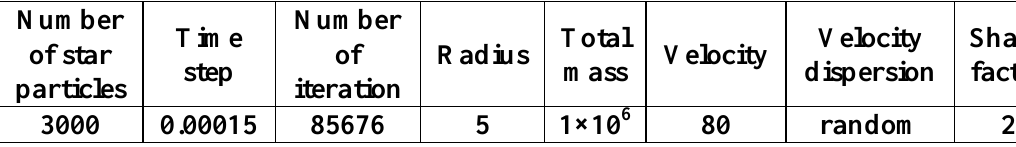
Table 2: Parameters of simulation for elliptical distribution model under MOND